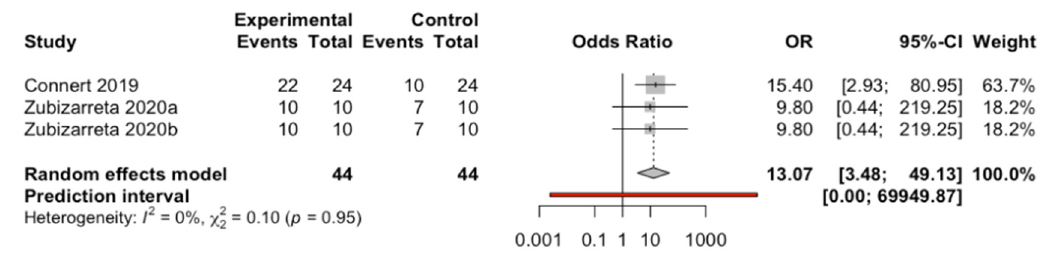
Figure 5. Forest plot of root canal location success OR between computer-aided navigation techniques and control group. The horizontal axis expresses the root canal proportion success rate of each study.